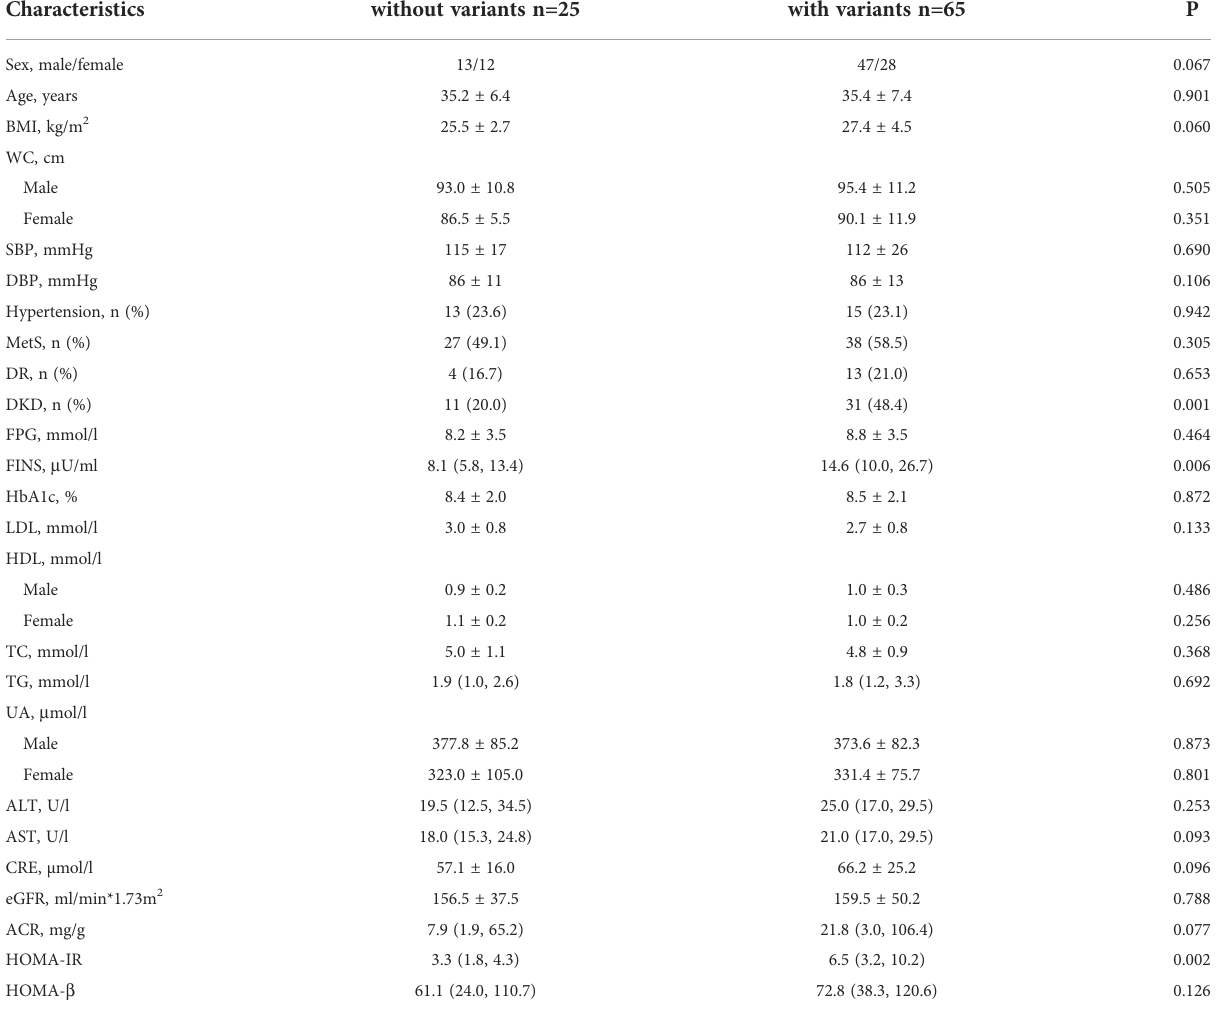
TABLE 4 Comparison of subjects with the 42 variants of mtDNA with the subjects without those variants in cohort 2.